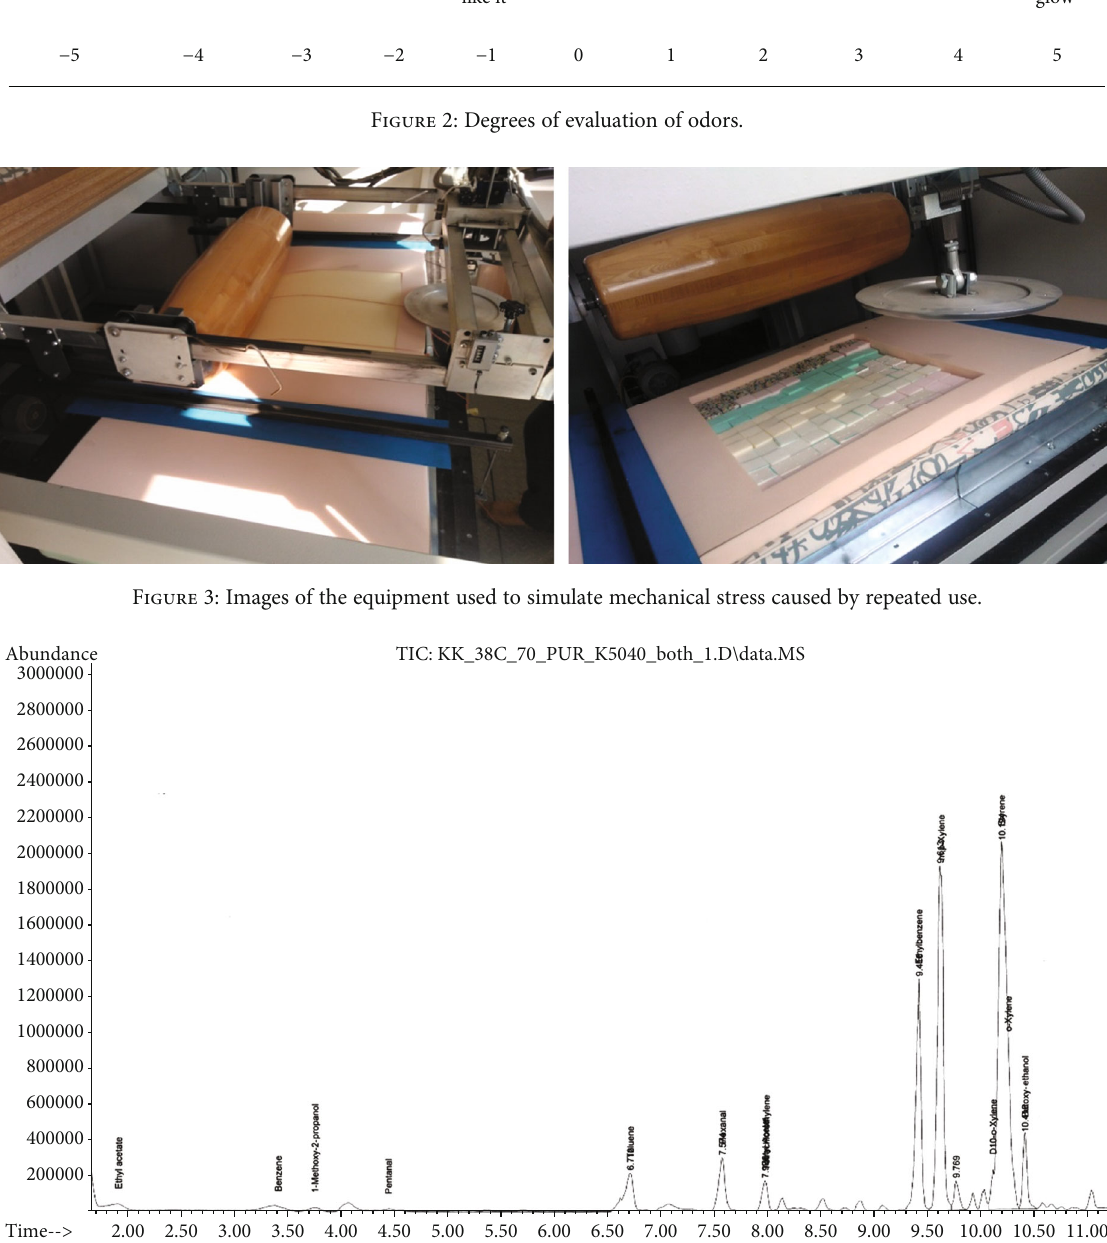
Figure 4: Representative chromatogram with internal standard and VOC